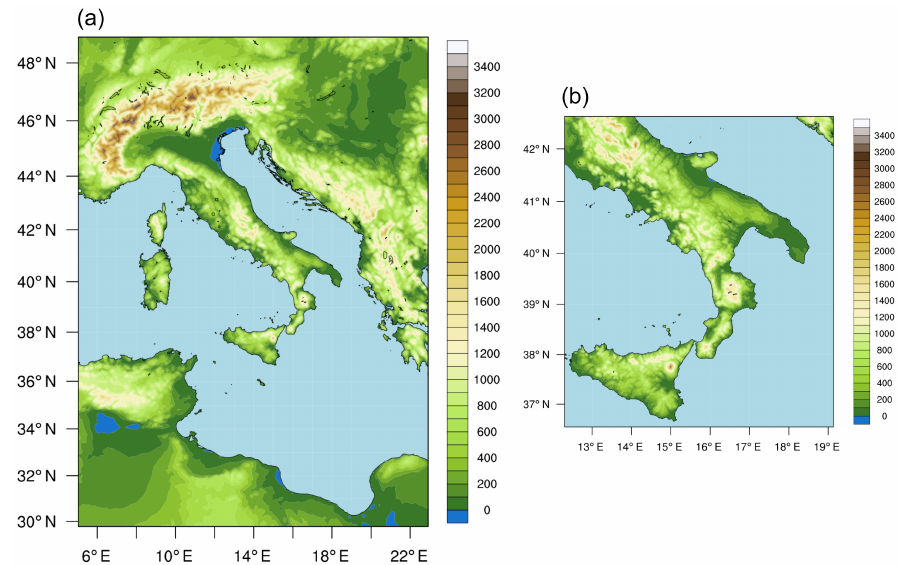
Figure 1. The study area. (a) WRF coarse domain (EEA SRTM topography dataset). (b) WRF inner and WRF-Hydro domain (EEA EU-DEM topography